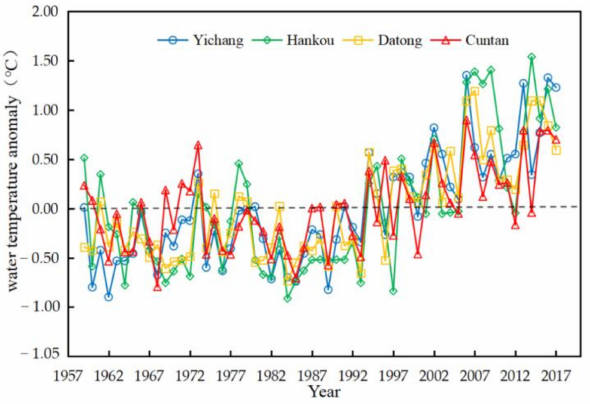
Figure 3. Temperature anomaly diagram of the Yangtze River.